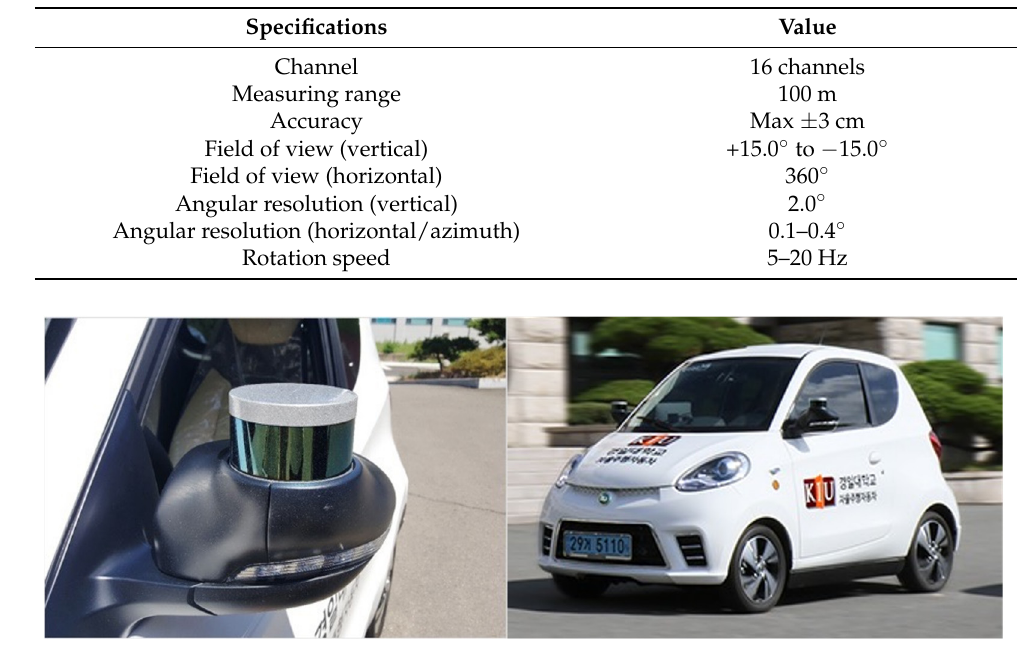
3. Results Figure 8 is a pictorial representation of the results of Figure 9a. In Figure 8, green is the free space that the vehicle can drive in. In the figure, red is a space in which the ve- hicle is completely unable to drive, and orange is a space in which the vehicle is unable to drive. The dotted line represents the grid map range, and the yellow represents the obstacle. The direction in which the obstacle moves is represented by an arrow, and the static obstacle is represented by a square dot. The driving target point is indicated by a gray circle. Paths are generated only in free space cells, and the generated paths are in- dicated by blue lines. By referring to this pictogram, the execution result screen of Figure 9 can be grasped.